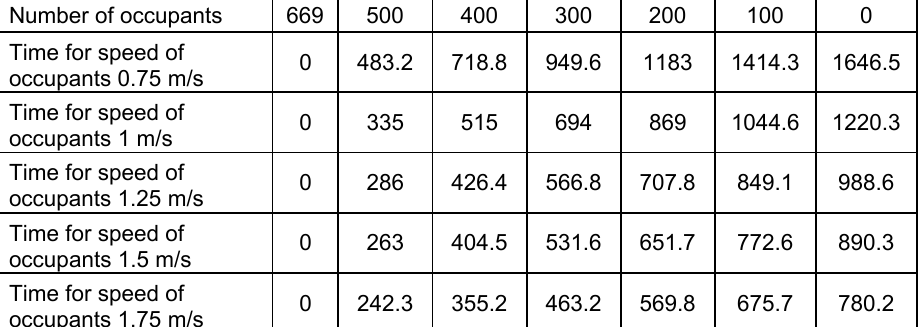
Table 24 – Simulation results in seconds for the fourth scenario, with elevators enabled and the second entrance/exit opened, while the first, the third and the fourth entrances/exits are blocked, and for the occupants’ speeds from 0.75 m/s, 1 m/s, 1.25 m/s, 1.5 m/s, and 1.75 m/s Таблица 24 – Результаты симуляции , выраженные в секундах по четвертому первый , третий и четвертый входы / выходы заблокированы , учитывая скорость